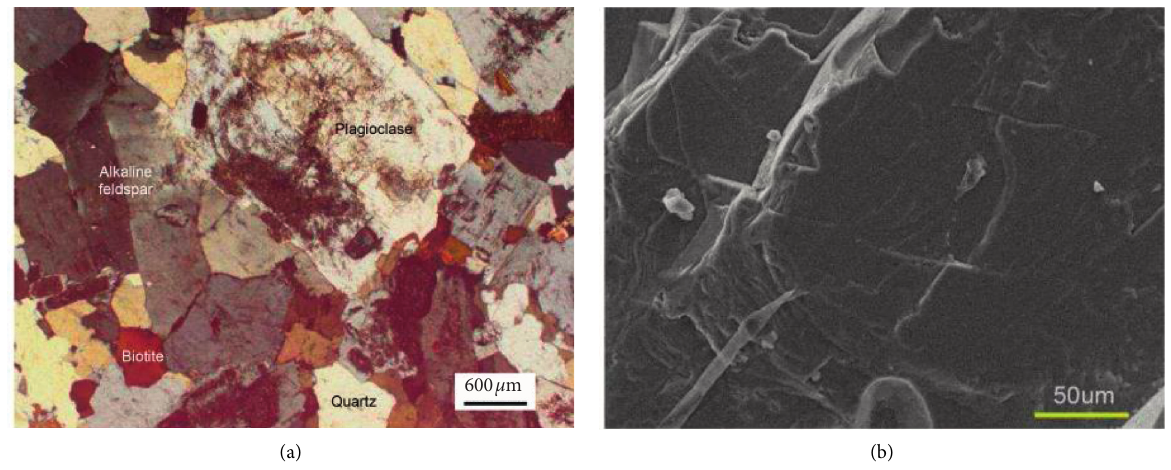
Figure 3: Observations of medium-grained monzogranite at different scales.